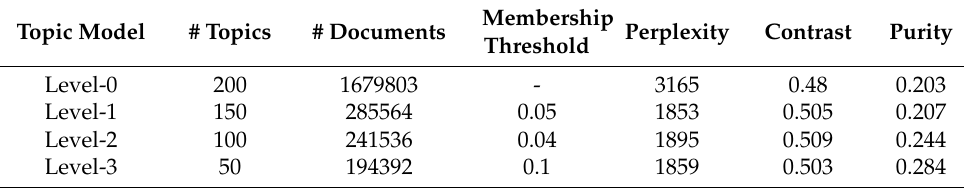
Table 3. Main information on the obtained topic